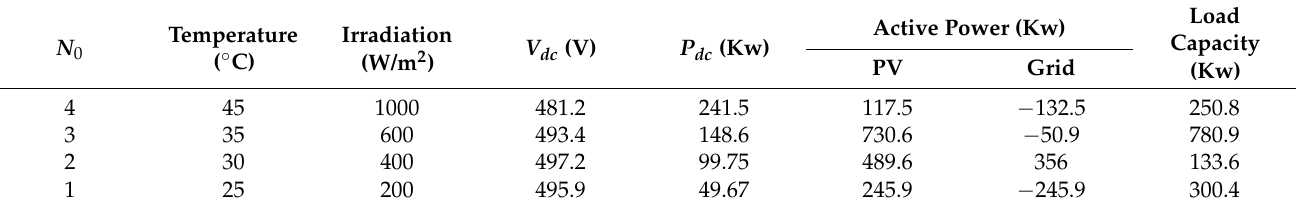
Table 3. Power flow simulation results for the planned system with various levels of solar irradiation.